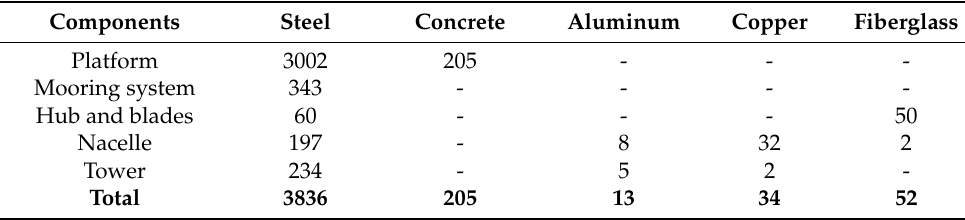
Table 1. Masses in the turbine for each material and components